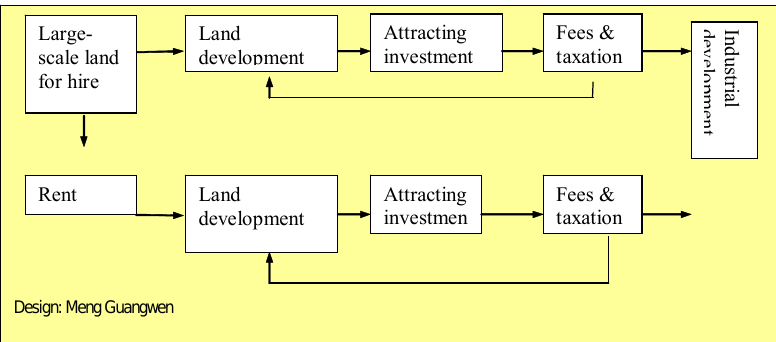
Fig. 3: The Model of Large-Scale Land and Industrial Development of Chinese